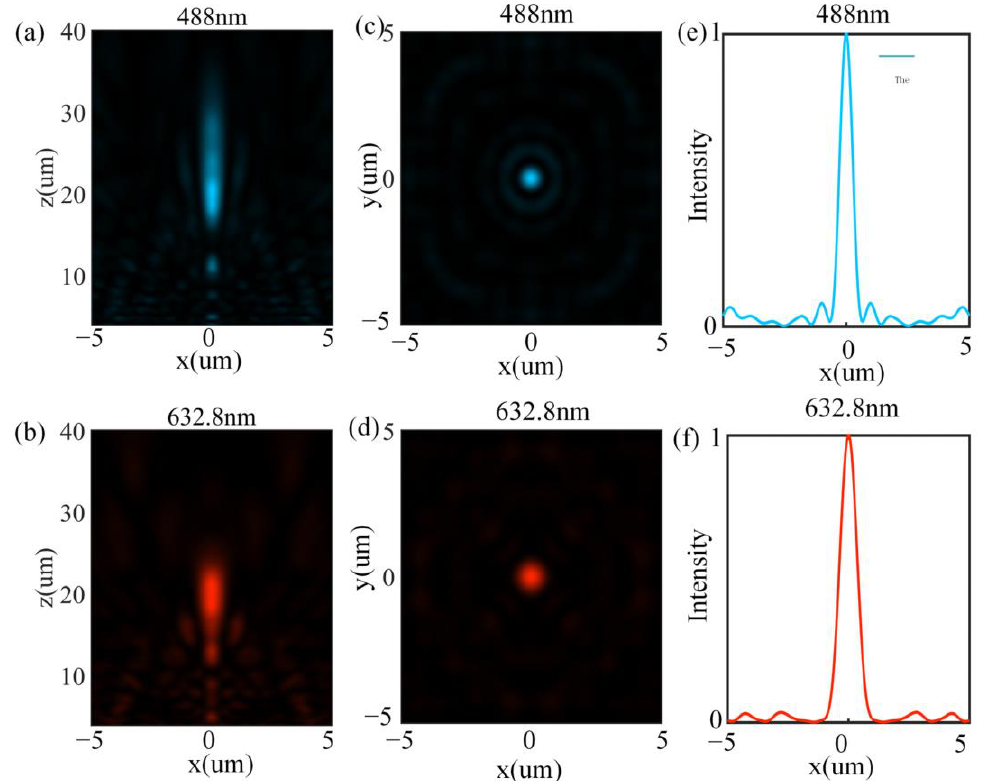
Figure 5. ( a ) Normalized intensity distributions in the x-z plane at 488 nm; ( b ) normalized intensity distributions in the x-z plane at 632.8 nm; ( c ) normalized intensity distributions of focal spots in the x-y plane at 488 nm; ( d ) normalized intensity distributions of focal spots in the x-y plane at 632.8 nm; ( e ) the corresponding cross-sectional intensity cut through the focal plane at 488 nm; ( f ) the corresponding cross-sectional intensity cut through the focal plane at 632.8 nm.